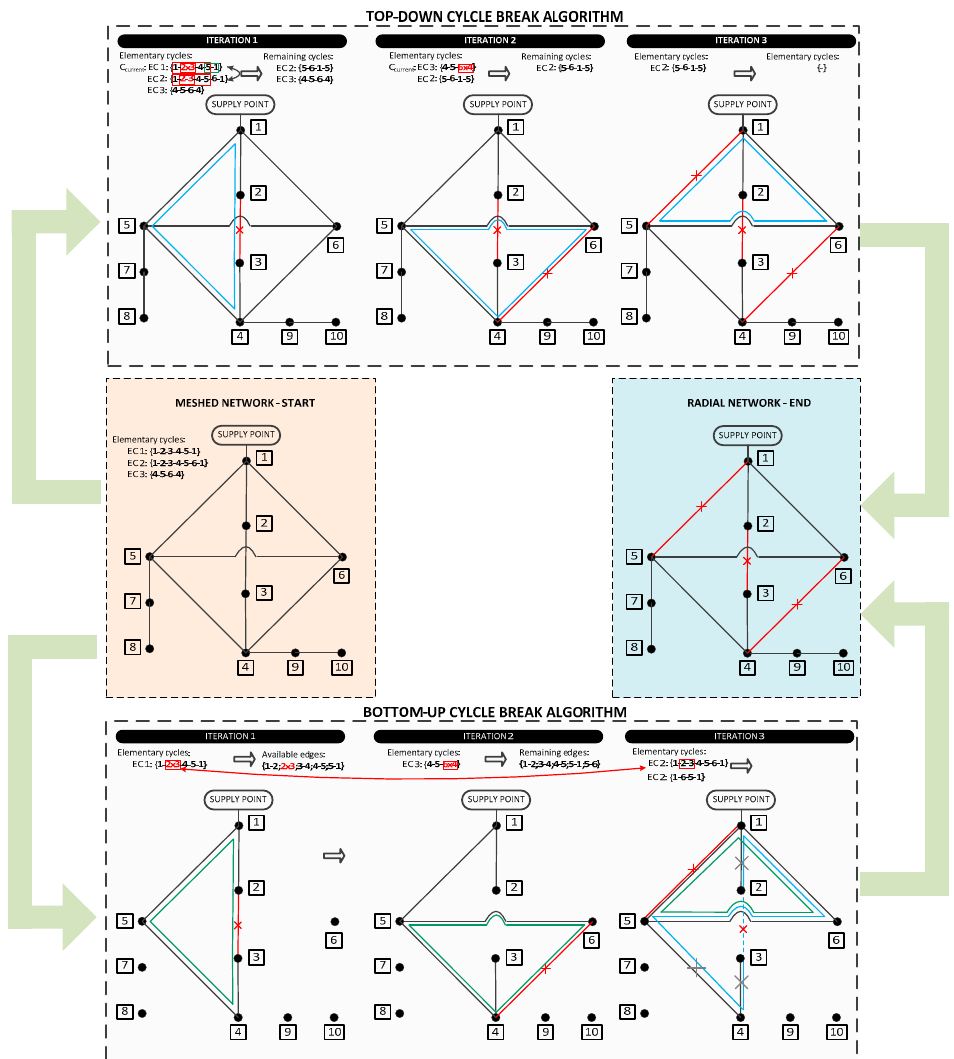
Figure 4. Illustration of TD and BU cycle break algorithms.